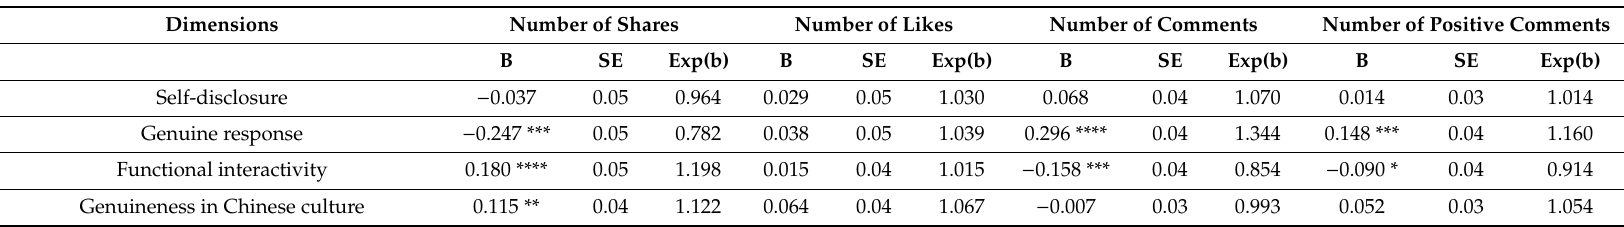
Table 4. Negative Binomial Regression Results on the Four Dimensions of Genuineness and the Number of Shares, Likes, Comments and Positive Comments.